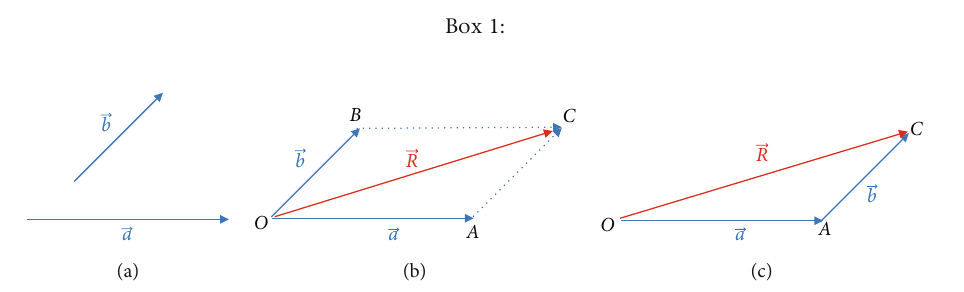
Figure 1: (a) Two randomly oriented vectors a ! and b ! in a plane; (b) parallelogram law: the resultant R ! = a ! + b ! lies along the diagonal of the parallelogram whose adjacent sides are formed by the vectors a ! and b of the triangle whose fi rst and second sides are formed by the vectors a ! and b